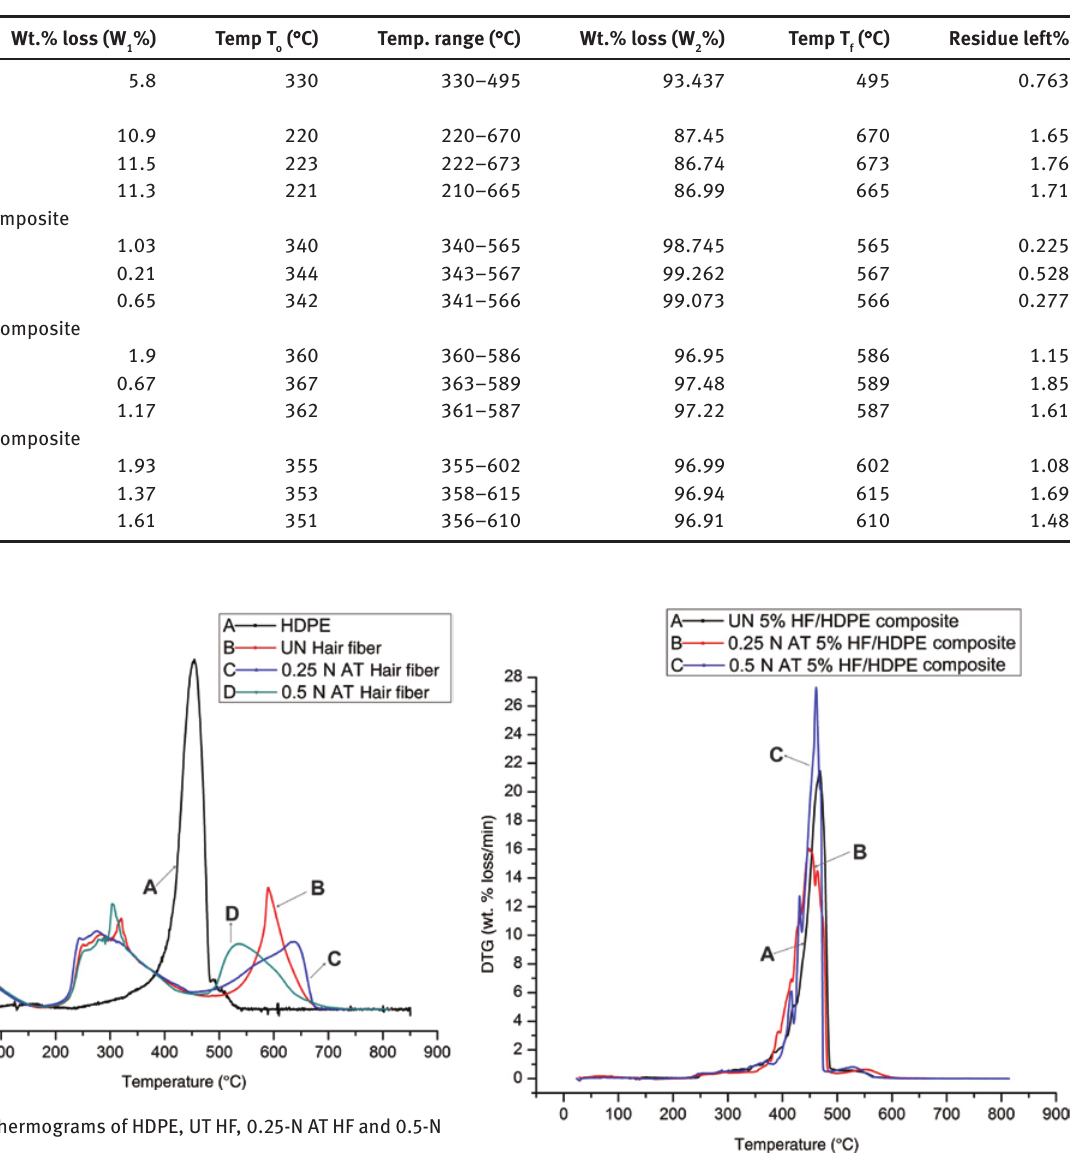
Figure 8: DTG thermograms of untreated and treated 5% HF/HDPE